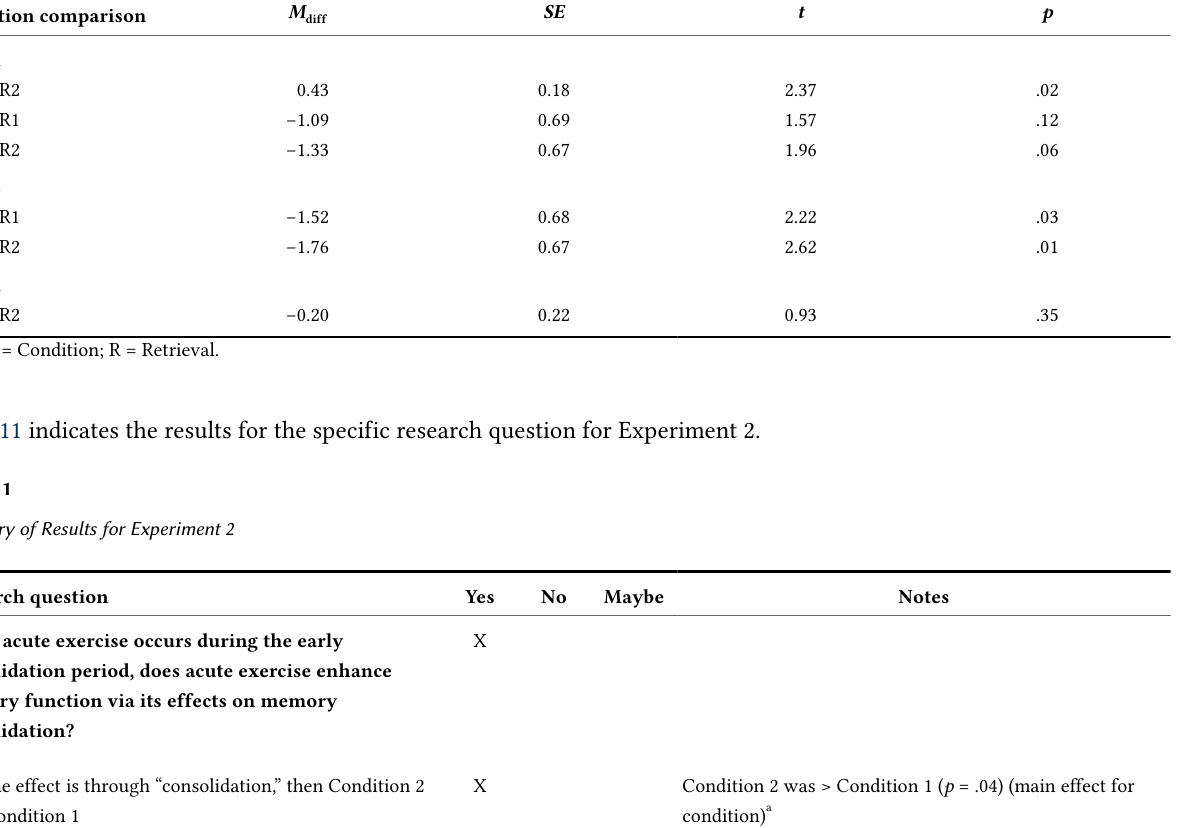
Post-Hoc Results Comparing the Memory Results Across the Experimental Conditions (Results Evaluated Across Condition and Time Period)